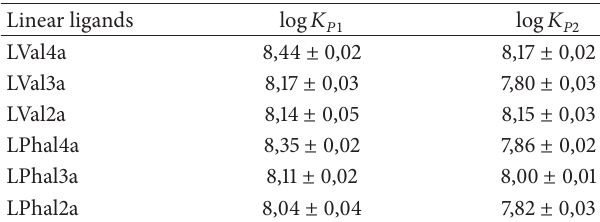
Table 1: Logarithm values of successive protonation constants